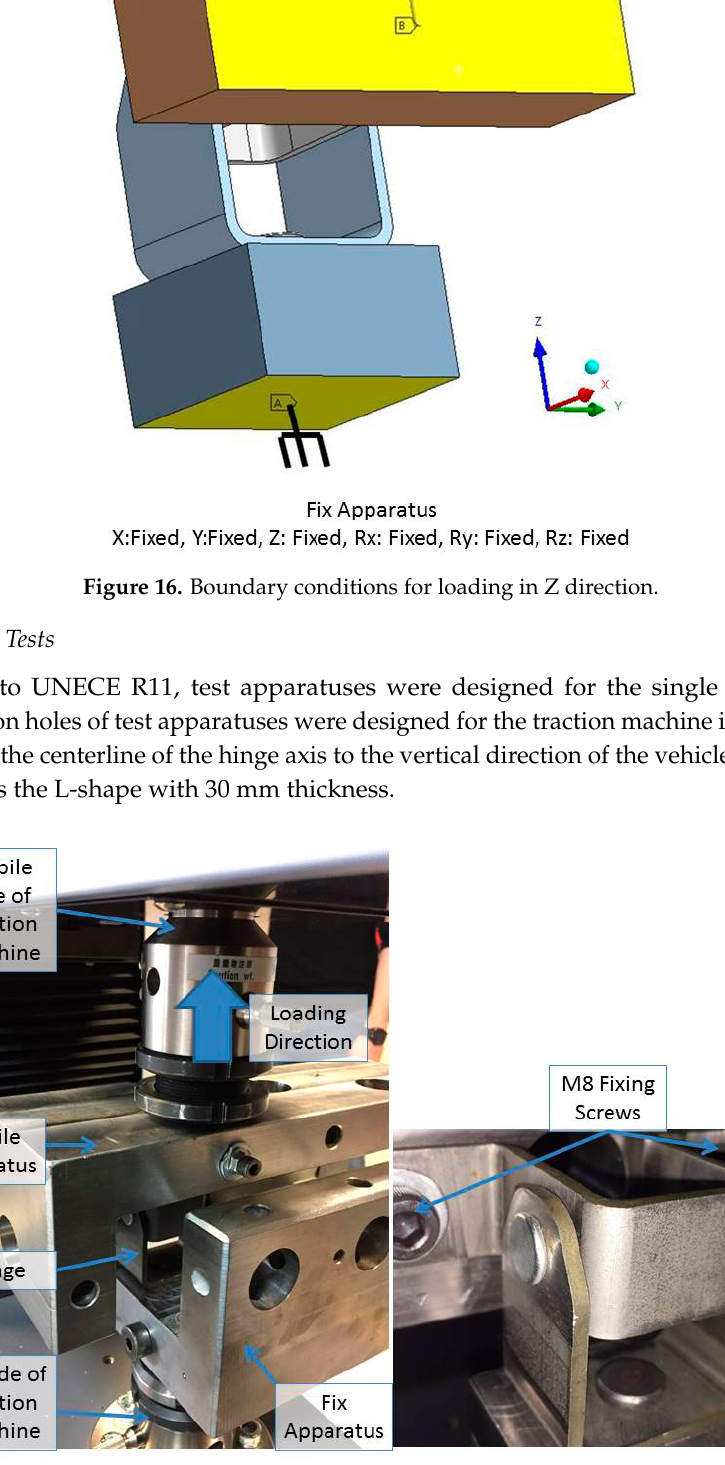
Figure 18. Tensile test machine configurations (( A ) tensile test machine, ( B ) load cell).